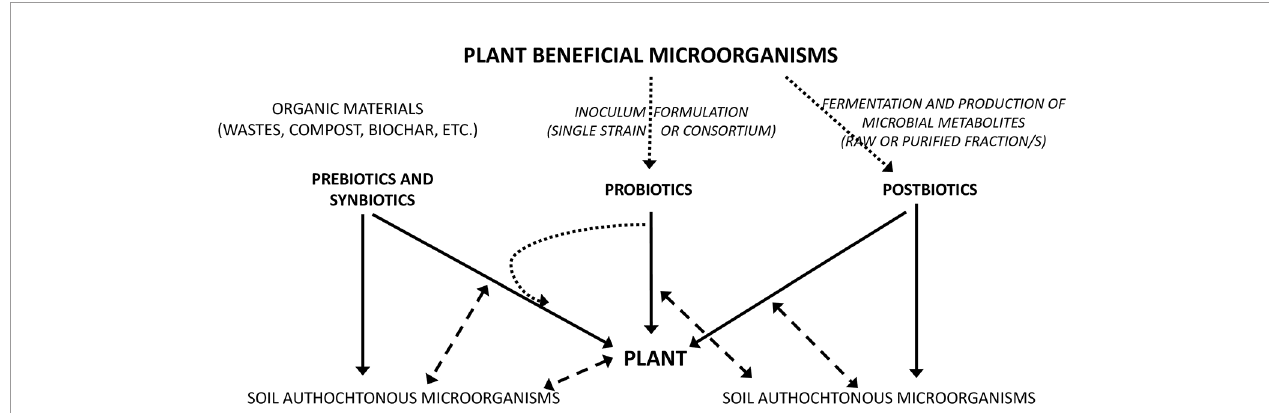
FIGURE 1 | Diagram showing the three strategies for microbial management of soil – plant based on prebiotics, probiotics, and postbiotics approaches. Full lines show the direct effect, dashed lines show the interactions, dotted lines — the formulation/production